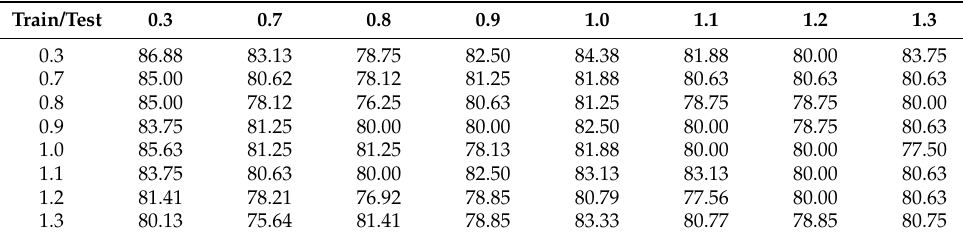
Table 5. Accuracy obtained by FN 512 with different resizing factors (reported in percentage).